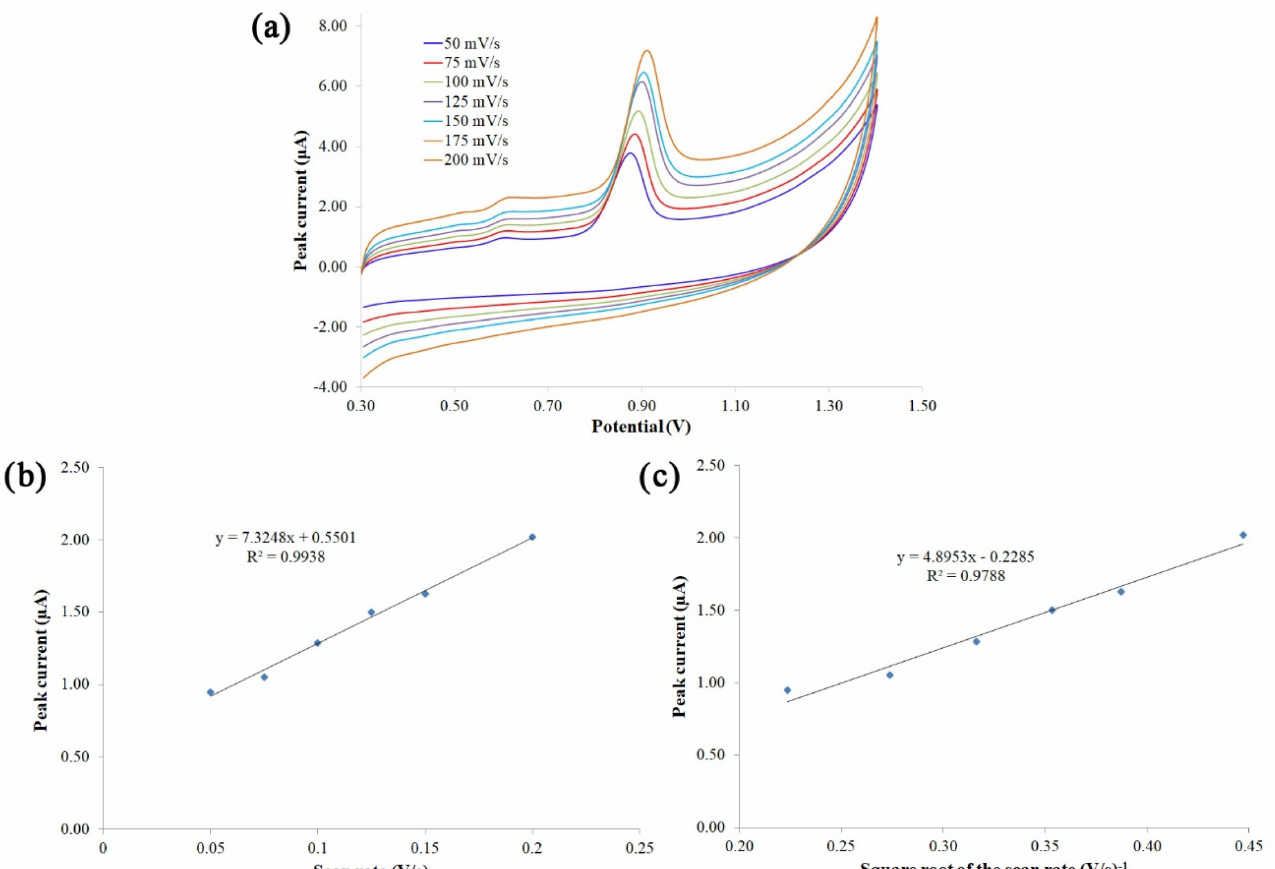
Figure 4. Cyclic voltammograms of tryptophan at different scan rates ( a ) (50 (blue), 75 (red), 100 (light green), 125 (purple), 150 (light blue), and 200 (orange) mV s − 1 ), plot of peak current vs. scan rate ( b ), and plot of peak current vs. square root of scan rate ( c